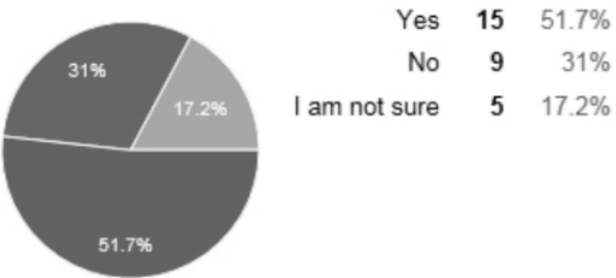
Figure 7. Distribution of responses to question Q1, asking whether AergiaML- like languages could help the respondent to communicate with software developers successfully